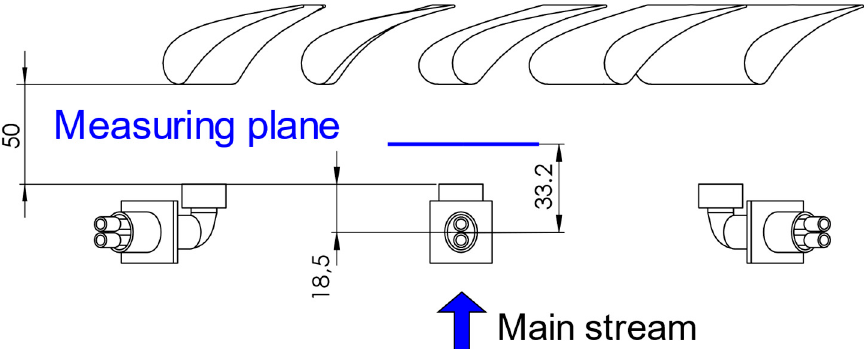
Figure 16. Measuring set-up for turbine measurements.